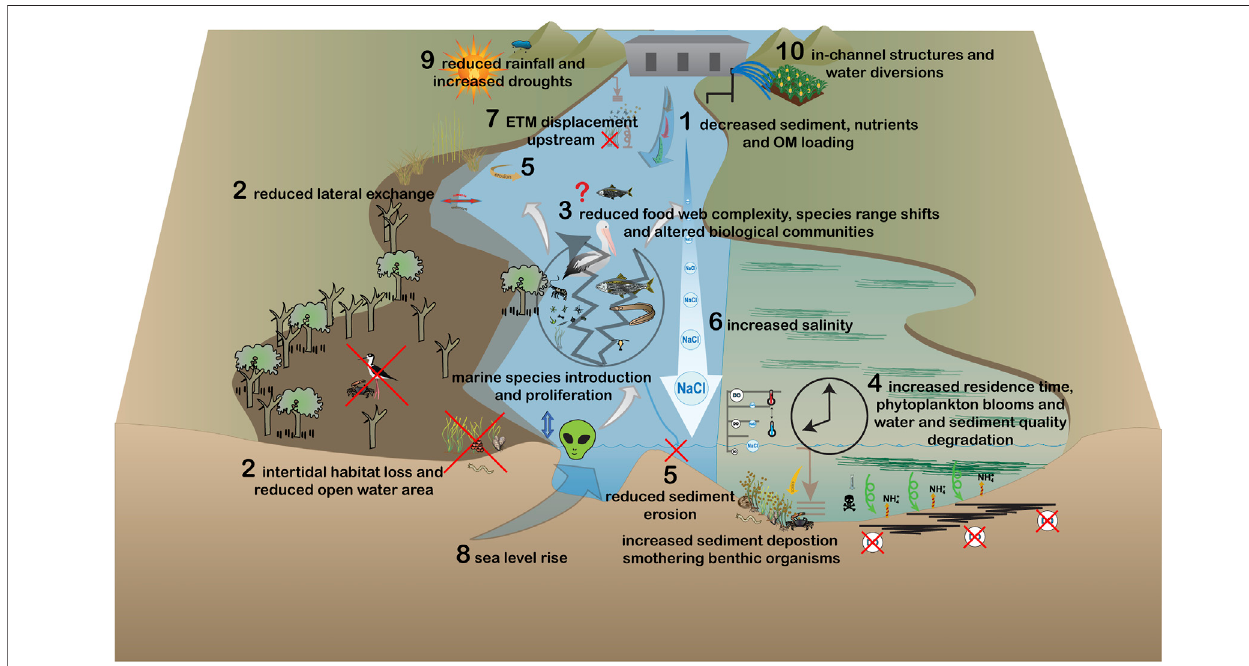
FIGURE 3 | Modi fi ed estuarine ecosystem processes under permanent decreases in fl ow volume and/or increases in the frequency and magnitude of drought. Impacts of this fl ow scenario are: 1) reduced delivery of organic matter, nutrients and sediments, 2) losses to intertidal and pelagic habitat structure, 3) reduced nutrient andenergytransferthroughthefoodweb,4)increasedresidencetimewithassociatedwaterqualitydecline,5)reducedsedimentscouring,6)increasedsalinityand7)a shift upstream of the ETM. Principal drivers of change are: 8) sea level rise, 9) reduced rainfall and increasing droughts, and 10) in-channel structures and water diversions.